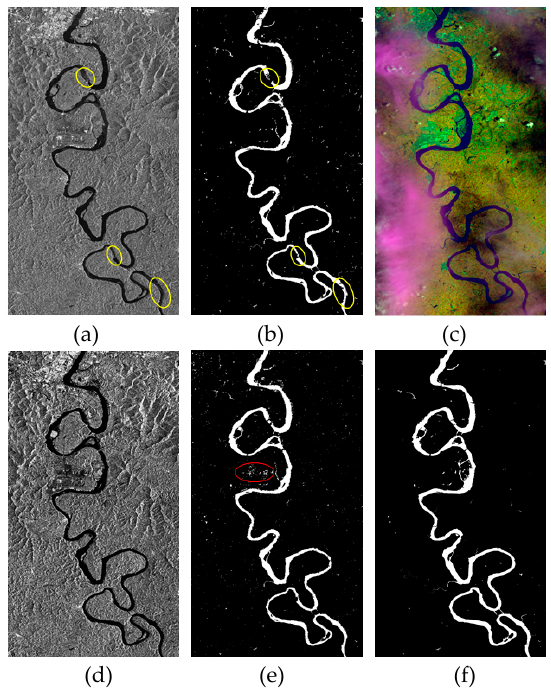
Figure 8. Flood detection results in the validation area. (a) S-1 VV image acquired on 15 July 2018; (b) TRS_LM_RGA-based flood area using the VV image; (c) Landsat-8 images (RGB: 5-6-4) acquired on 16 July